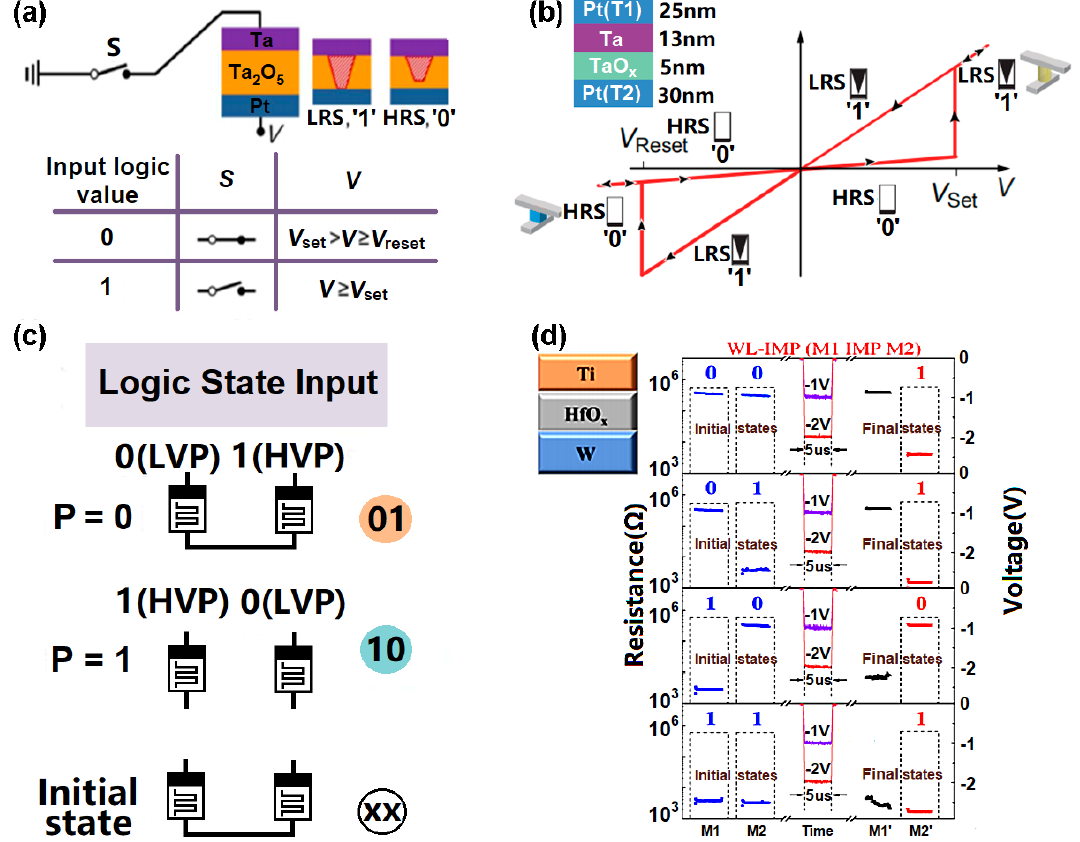
Figure 17. Various RRAM configurations: ( a ) a hybrid device structure with one switch and one unipolar RRAM cell; ( b ) the I-V characteristics of a typical TaOx-based RRAM; ( c ) the logic operation of two anti-serial RRAM devices; ( d ) experimental results for “WL-IMP” operations on M1 and M2 (( a ) is reprinted with permission from [154]; ( b ) is reprinted with permission from [155]; ( c ) is reprinted with permission from [156]; ( d ) is reprinted with permission from